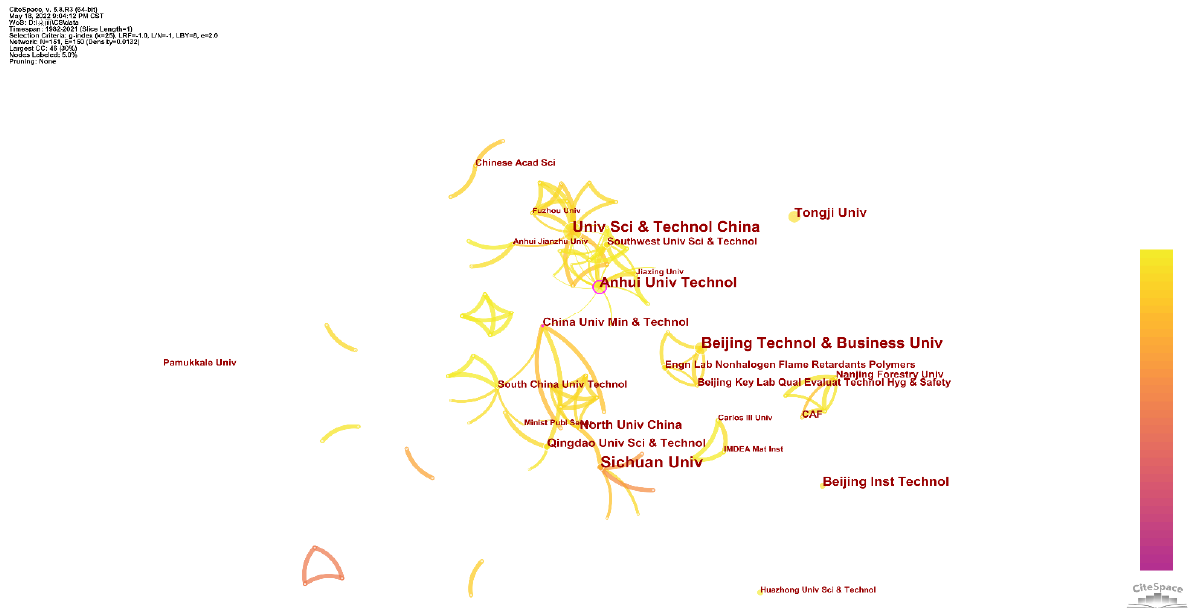
Figure 9. Institution cooperation network for flame-retardant RPUF. Table 3. List of top 15 keywords for flame-retardant RPUF. No.